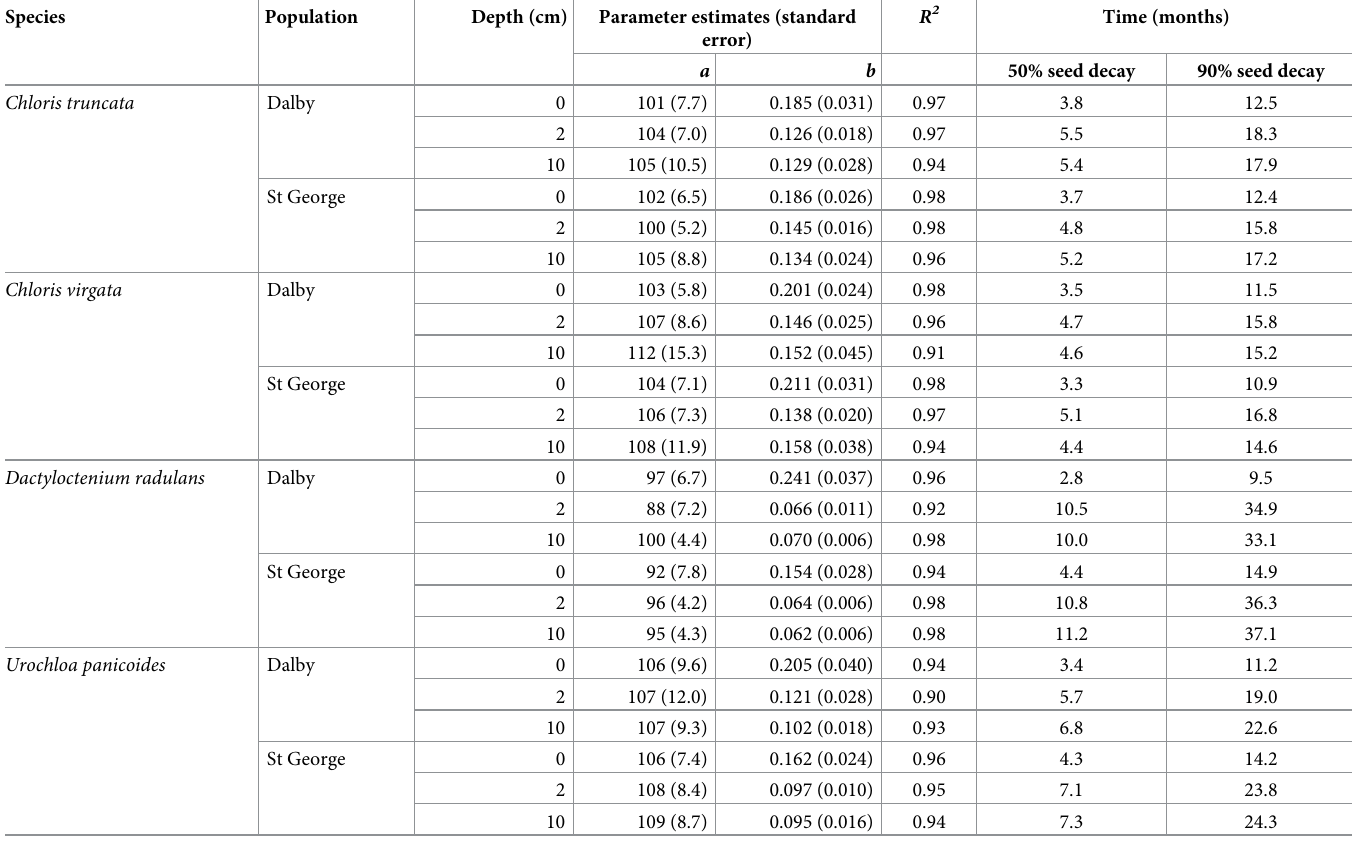
Table 1. Parameter estimates of a two-parameter exponential decay model [ SP = a � exp (- b � x ) ] fitted to the seed persistence data of two populations of each weed species. Species